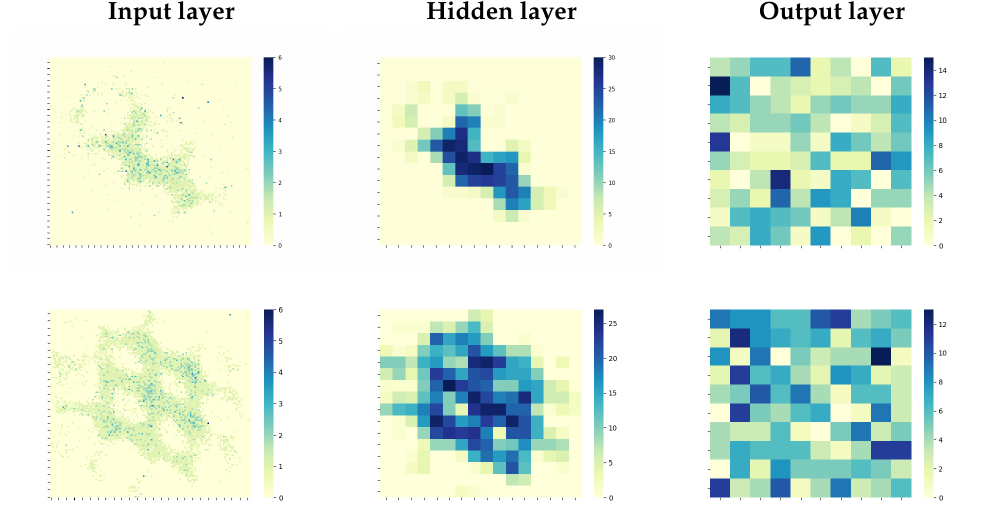
Figure 8. Heatmaps representing the spatial distribution of activity (degree of heat represents spike count per neuron) as data passes through each layer of the SNN. The left panel displays the spike activity in the input layer with a 128 × 128 layout, the middle panel represents the hidden layer with an optimal 16 × 16 layout, and the right panel the output layer with optimal n output = 100. The top row shows data for the tapping experiment and the bottom row for the sliding